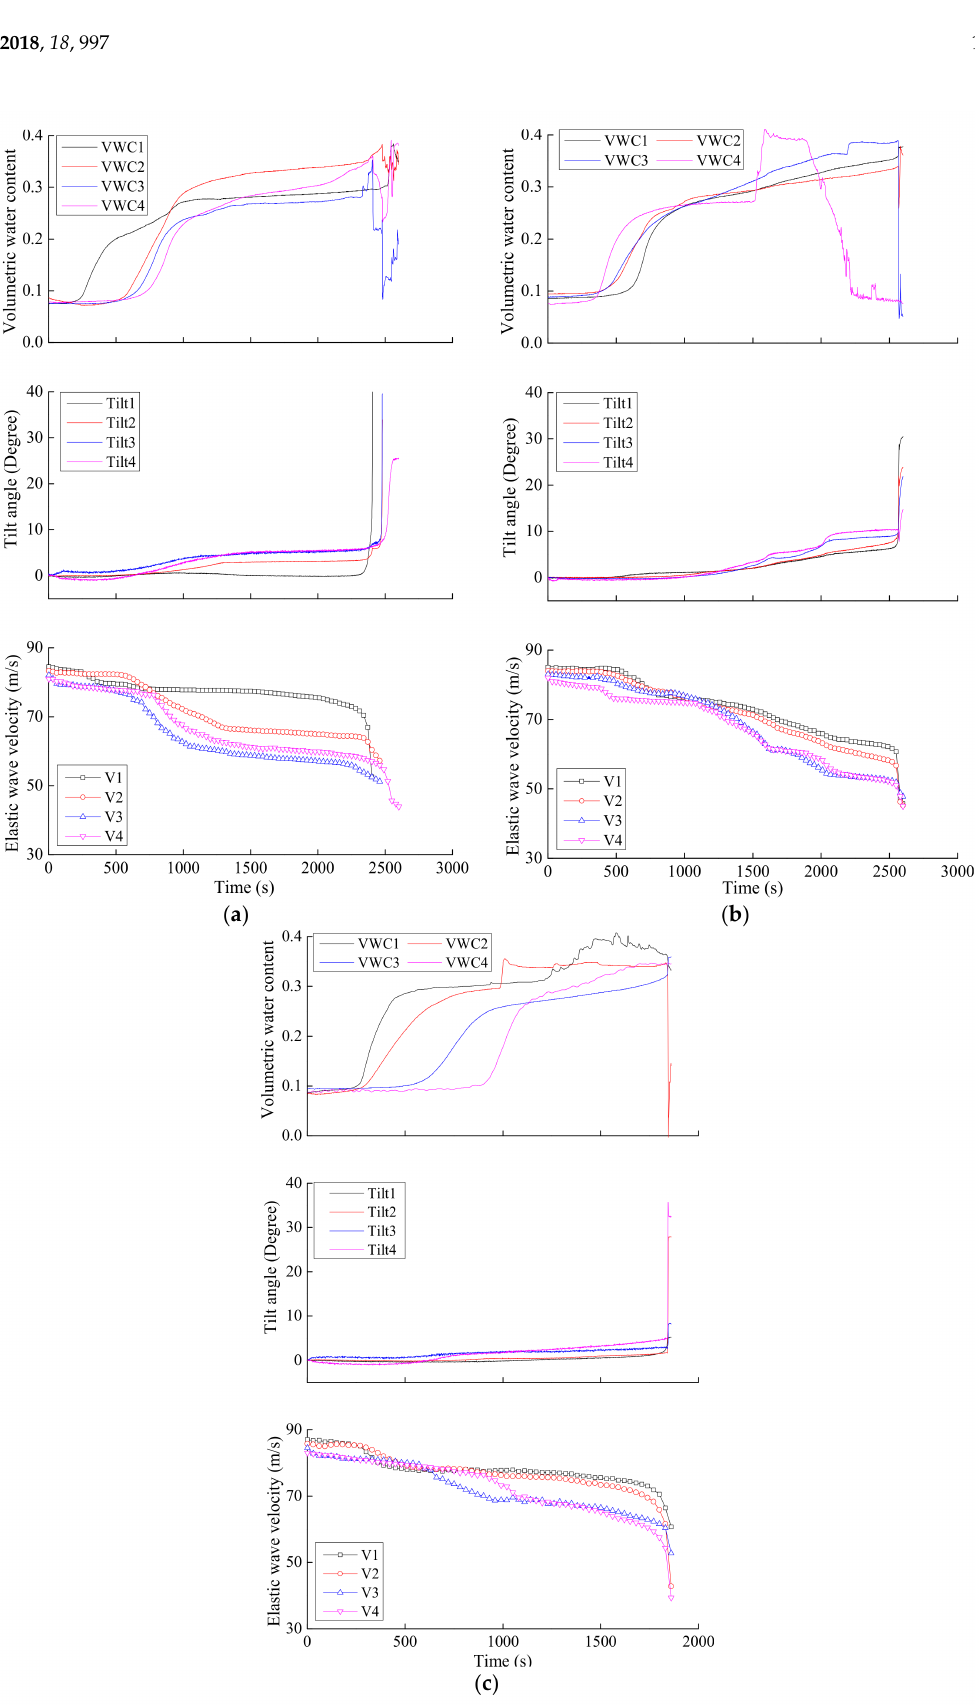
Figure 9. Time series data of volumetric water content, tilt angle and elastic wave velocity by fixed model tests with surface layer thickness of ( a ) 5 cm, ( b ) 10 cm and ( c ) 15